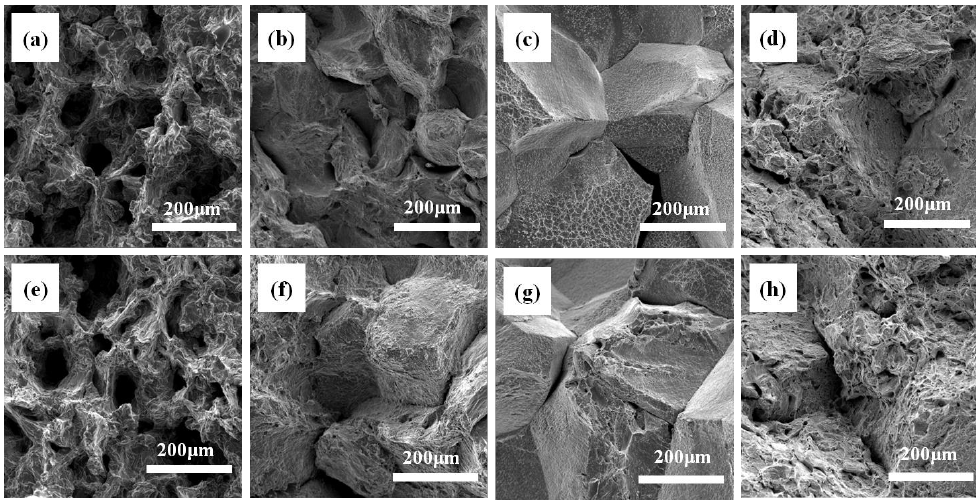
Figure10. FracturemorphologyofSbsteelandSb + Snsteelatdi ff erenttemperatures. ( a )Sbsteel-1100 ◦ C; Figure 10. Fracture morphology of Sb steel and Sb+Sn steel at different temperatures. ( a ) Sb ( b ) Sb steel-850 ◦ C; ( c ) Sb steel-750 ◦ C; ( d ) Sb steel-650 ◦ C; ( e ) Sb + Sn steel-1100 ◦ C; ( f ) Sb + Sn steel-850 ◦ C; steel-1100 °C; ( b ) Sb steel-850 °C; ( c ) Sb steel-750 °C; ( d ) Sb steel-650 °C; ( e ) Sb+Sn steel-1100 °C; ( f ) ( g ) Sb + Sn steel-750 ◦ C; ( h ) Sb + Sn steel-650 ◦ C. Sb+Sn steel-850 °C; ( g ) Sb+Sn steel-750 °C; ( h ) Sb+Sn steel-650 °C. Microstructures of the specimens of Sb + Sn steel at di ff erent temperatures (1100